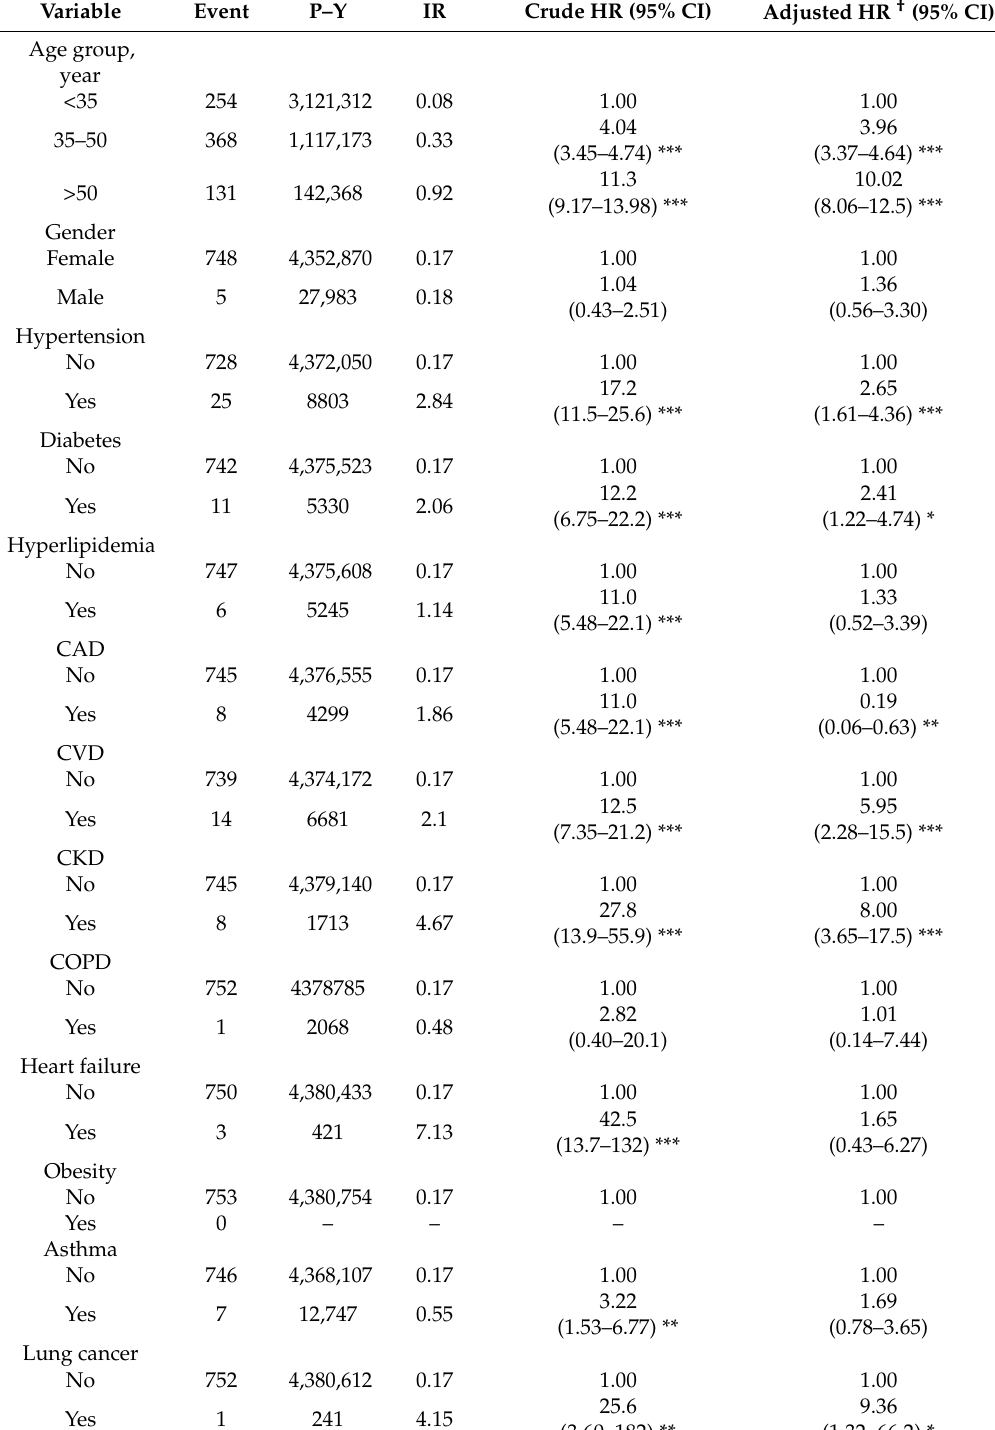
Table 3. Incidence rate and hazard ratio for hemorrhagic stroke, stratified with age, sex, and